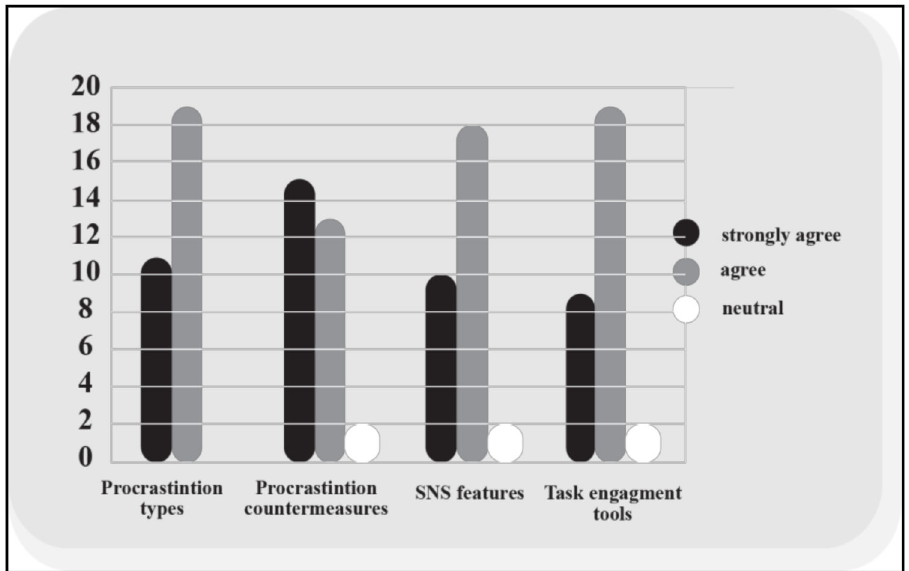
Figure 2. Coverage of